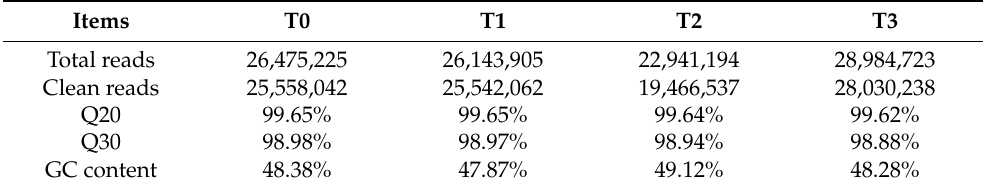
Table 2. Quality data of small RNA